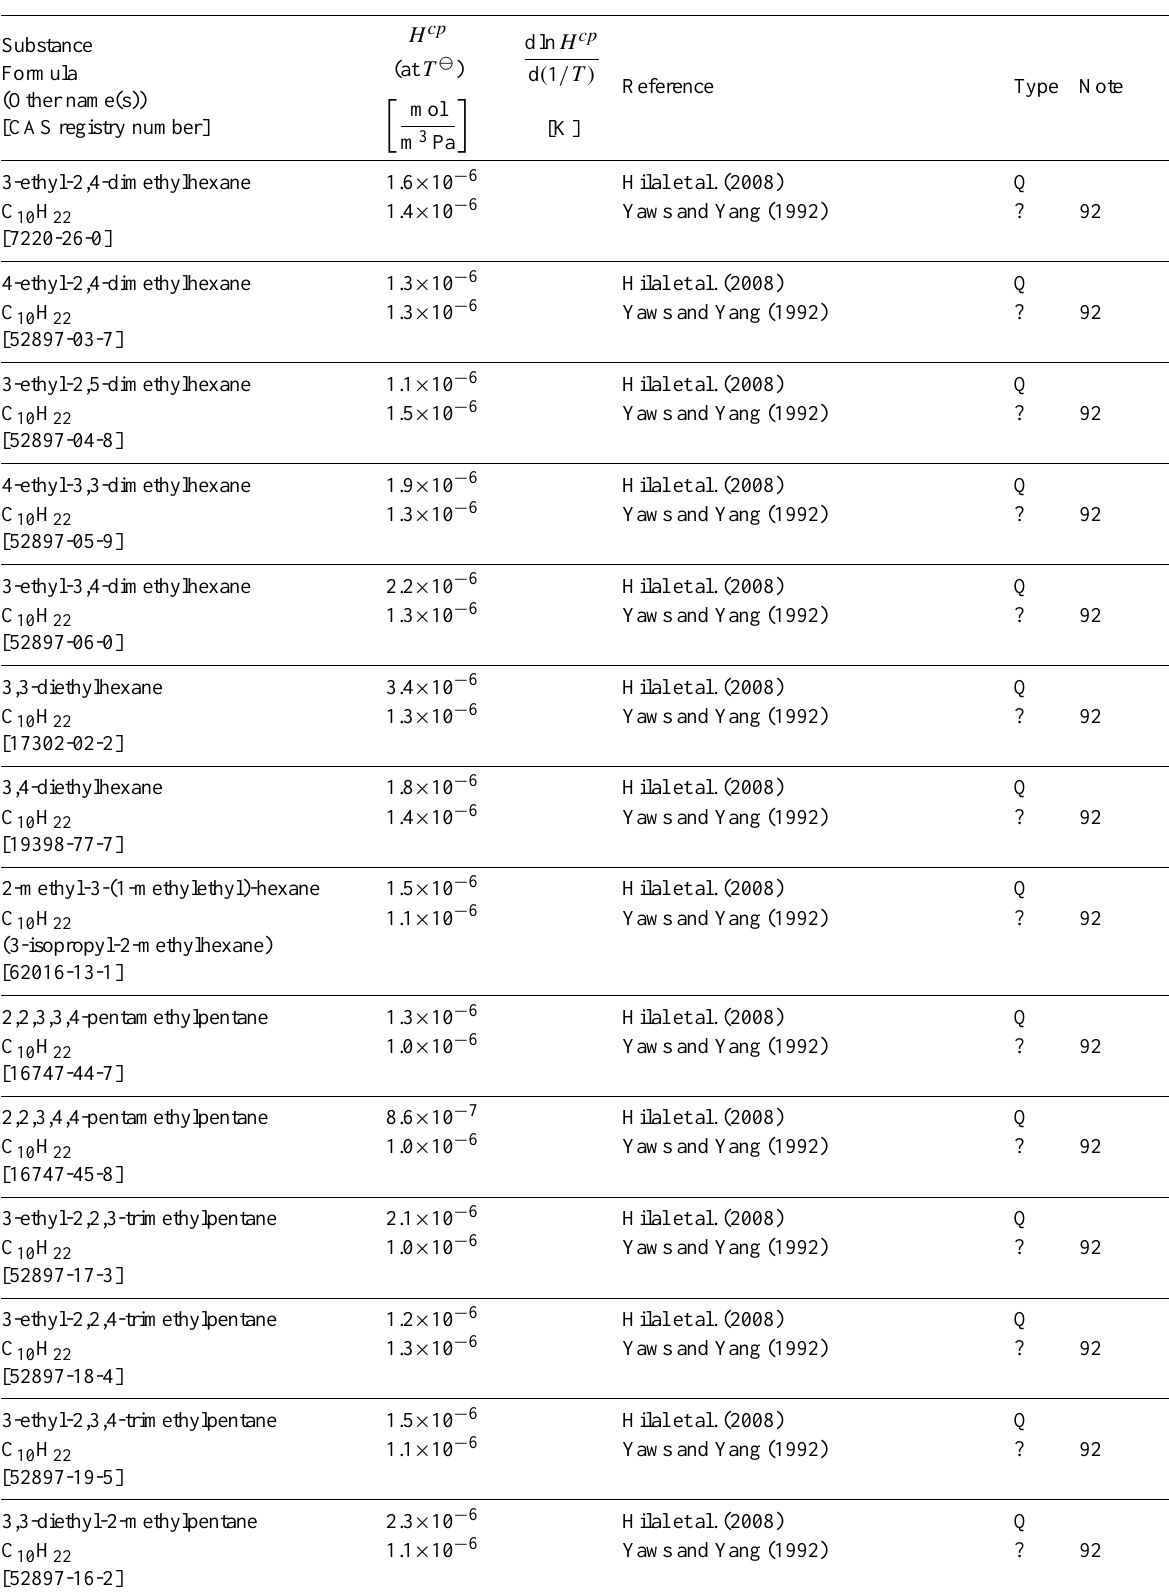
Table 6: Henry’s law constants for water as solvent